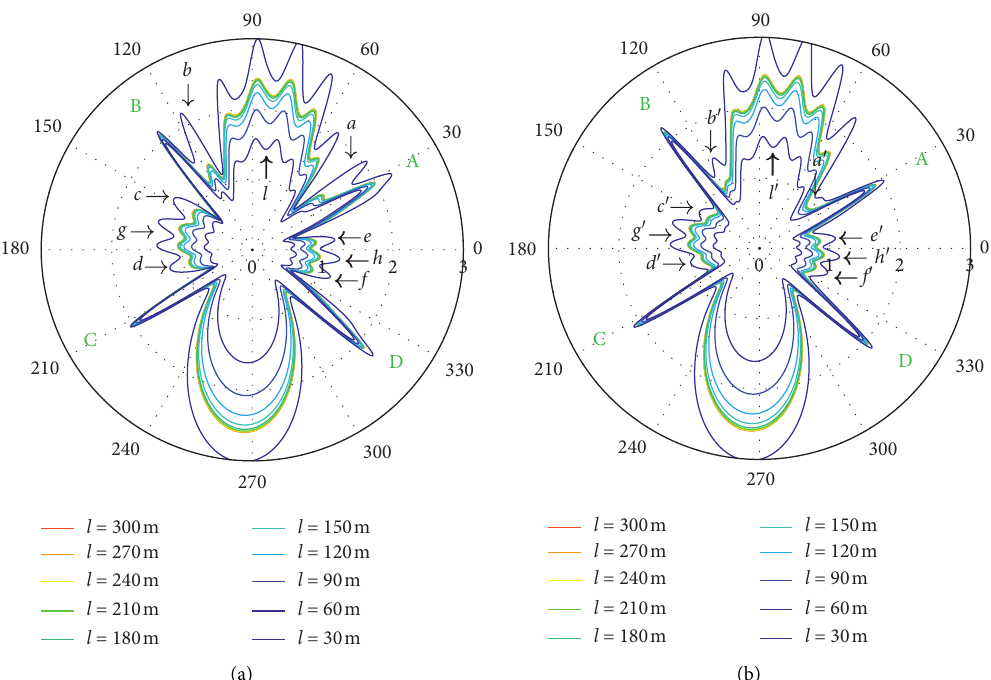
Figure 12: SRSI on the circumferential line of the end anchoring zone and the full-length anchoring zone. (a) Full-length anchoring. (b) End